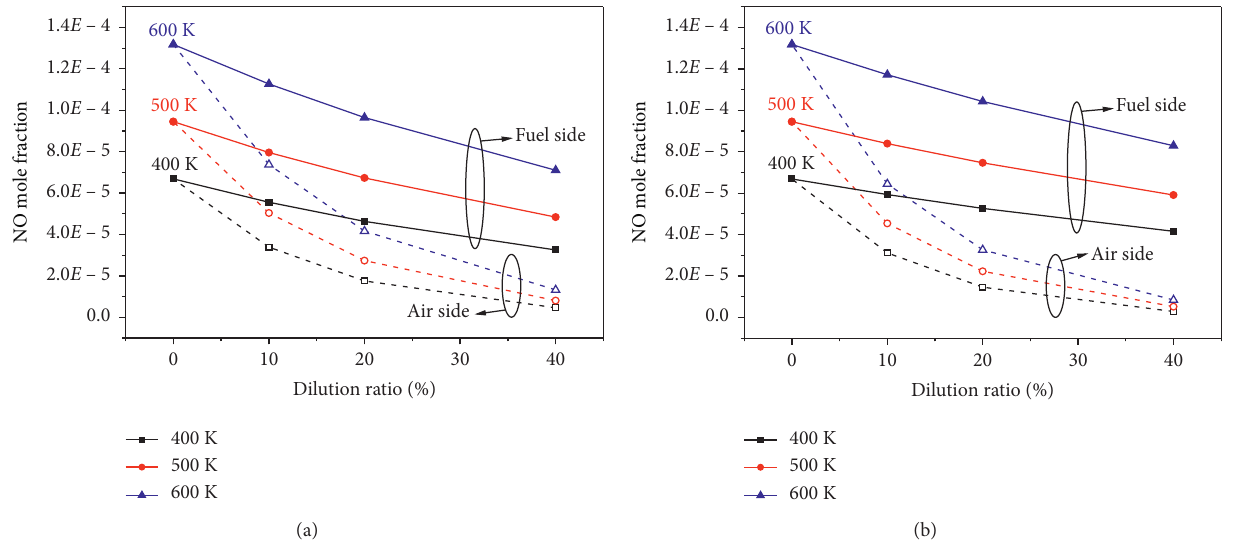
Figure 8: The peak NO mole fraction of CH 4 /air counterflow diffusion flames with different inlet temperatures: T (red), and 600K (blue). a s � 50s − 1 , L � 2 cm.